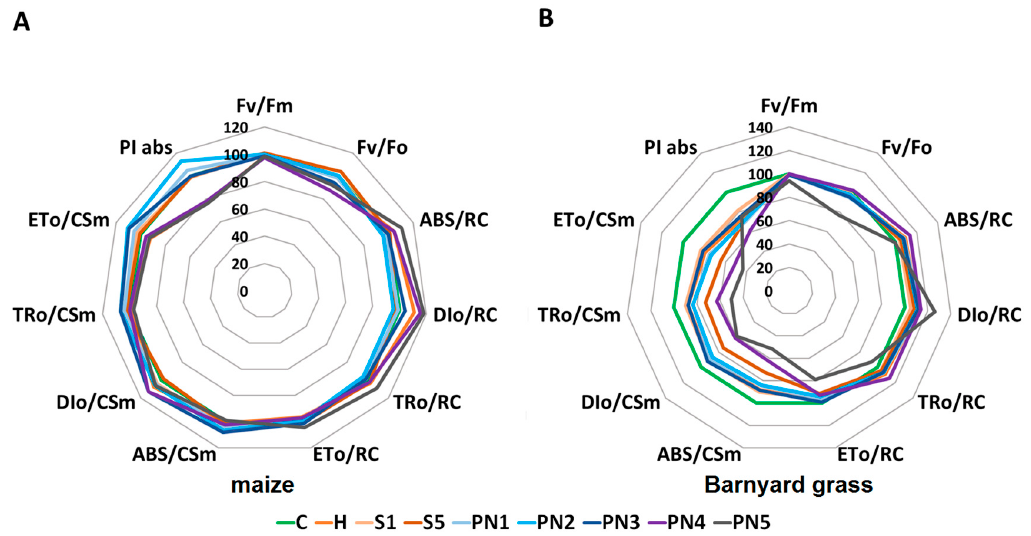
Figure 10. Values of selected Chl a fluorescence parameters of maize ( A ) and barnyard grass ( B ). C—water control, H—herbicide, surfactants S1 (1% v / v ) and S5 (10% v / v ), nanoemulsions with peppermint oil PN1 (1% v / v ), PN2 (1.5% v / v ), PN3 (2% v / v ), PN4 (5% v / v ), and PN5 (10% v / v ).